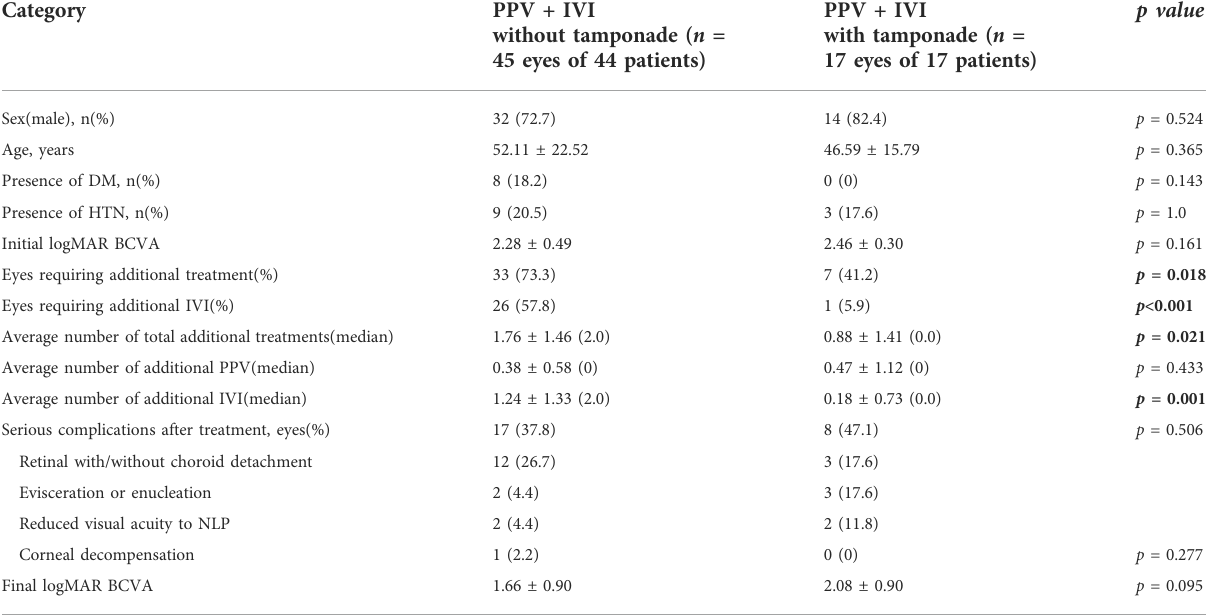
TABLE 5 Subgroup analysis according to whether silicone oil/gas tamponade was combined in Group 1.